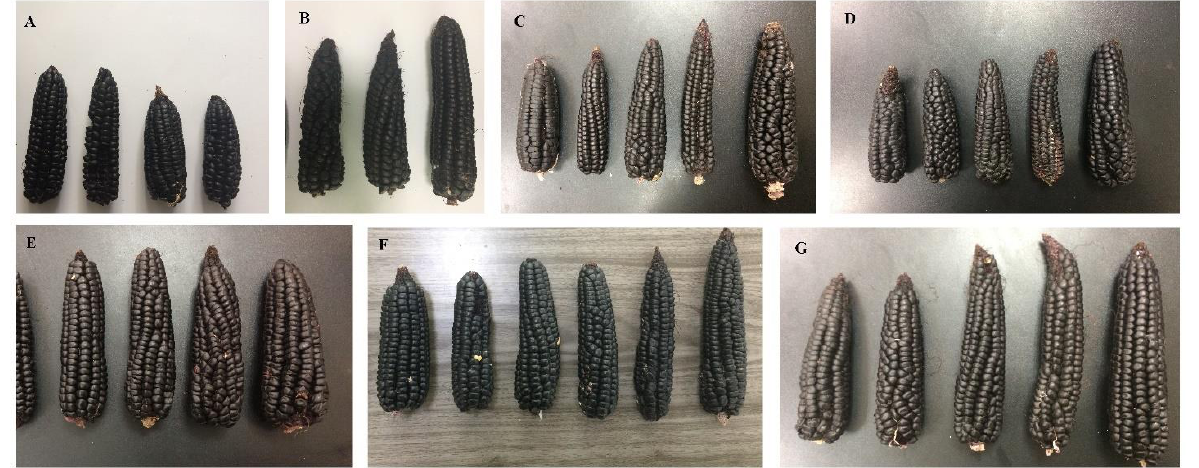
Figure 5. Photographs of the ears of corn plants of the Kculli race showing the arrangement of the grains per row. Ear samples from treatment T1 ( A ); treatment T2 ( B ); treatment T3 ( C ); treatment T4 ( D ); treatment T5 ( E ); treatment T6 ( F ); and treatment T7 ( G ).